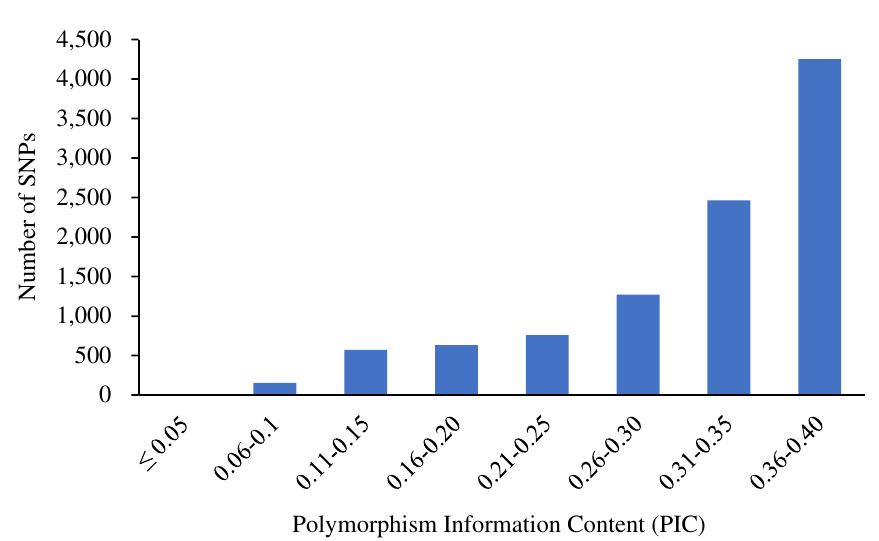
Figure 3. Distribution of polymorphic information content (PIC) values of 10,106 SNPs calculated for 214 tetraploid clones across 10,106